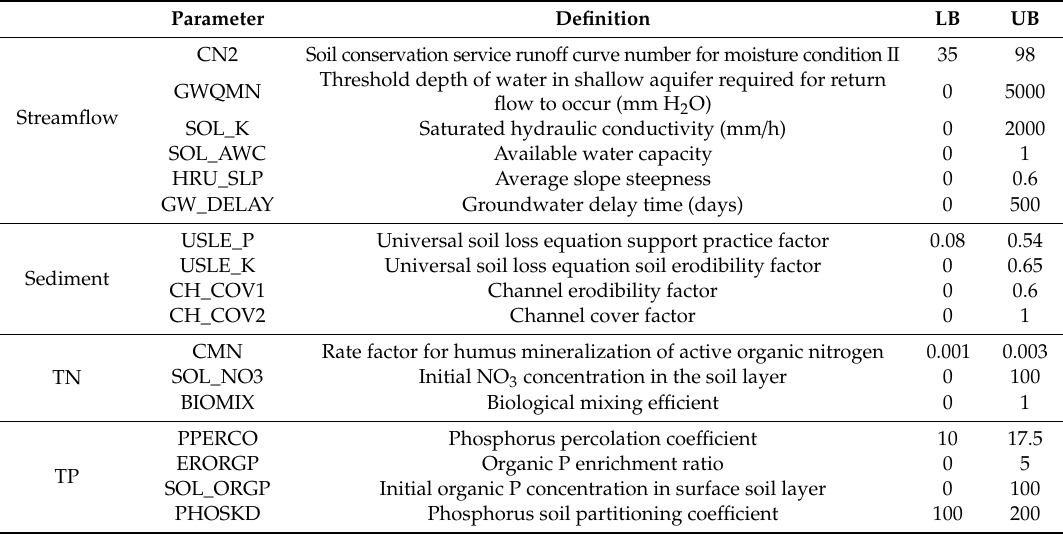
Table 4. Performance statistics of streamflow and water quality simulation.